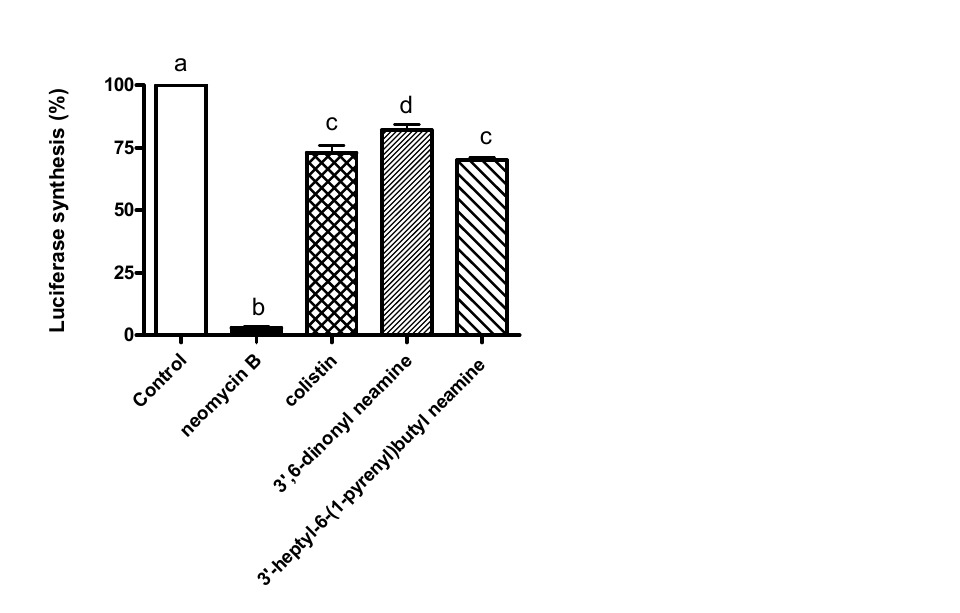
Figure 2. Percentage of luciferase synthesized in the absence (control) or presence (1 μ g/mL) of 3 ′ ,6- dinonylneamine (0.97 μ M), 3 ′ -heptyl-6-(1-pyrenyl)butyl neamine (0.88 μ M), neomycin B (1.63 μ M) (positive control), and colistin (0.86 μ M) (negative control) after 60 min of incubation in a plasmid S30 Extract E. coli . N = 2, n = 6. Statistical assays were one-way ANOVA analysis with Tukey’s multiple comparison test. In each group, the bars with different letters indicate significant differences ( p < 0.001).